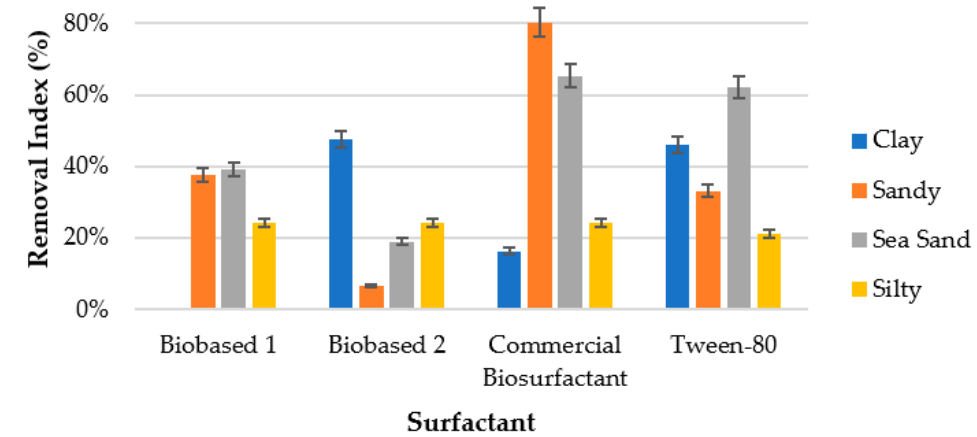
Figure 5. Removal of motor oil adsorbed to four types of soils in packed glass columns (static assay) using the four surfactants tested.